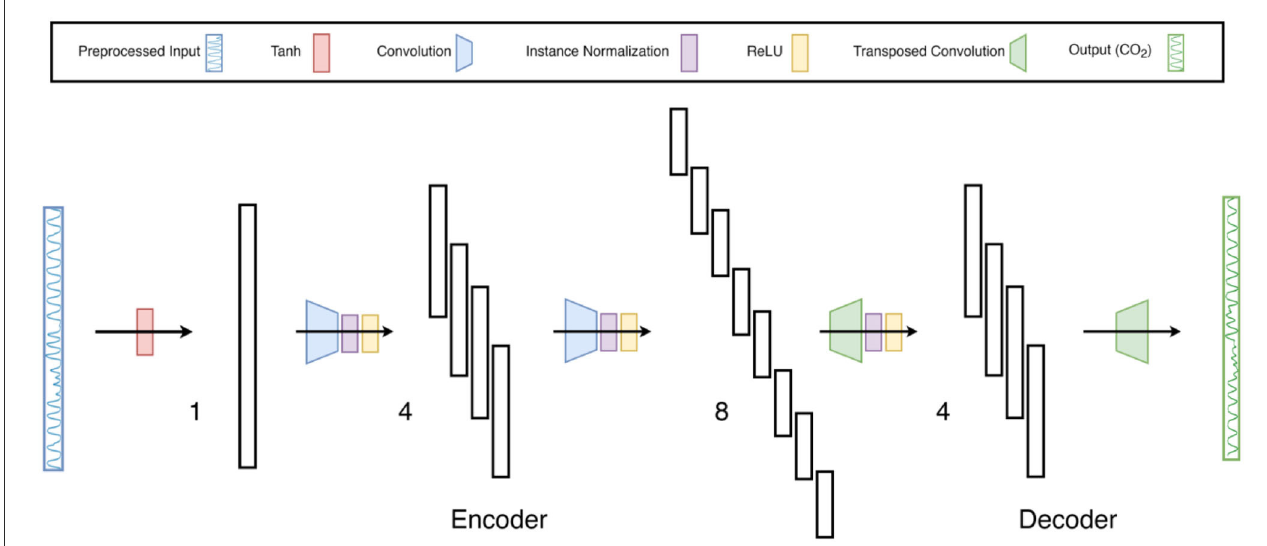
FIGURE3 Neural-network architecture: 4-Layer Fully Convolutional Network. The architecture shown here is a type of encoder-decoder neural network consisting of fully convolutional layers, followed by instance normalization and ReLu non-linearity. The last layer does not contain normalization and activation function as it is a regression problem. Moreover, the input is first normalized using tanh activation function to constrain the input data between − 1 and 1. The numbers 1, 4 and 8 indicate the number of filters per